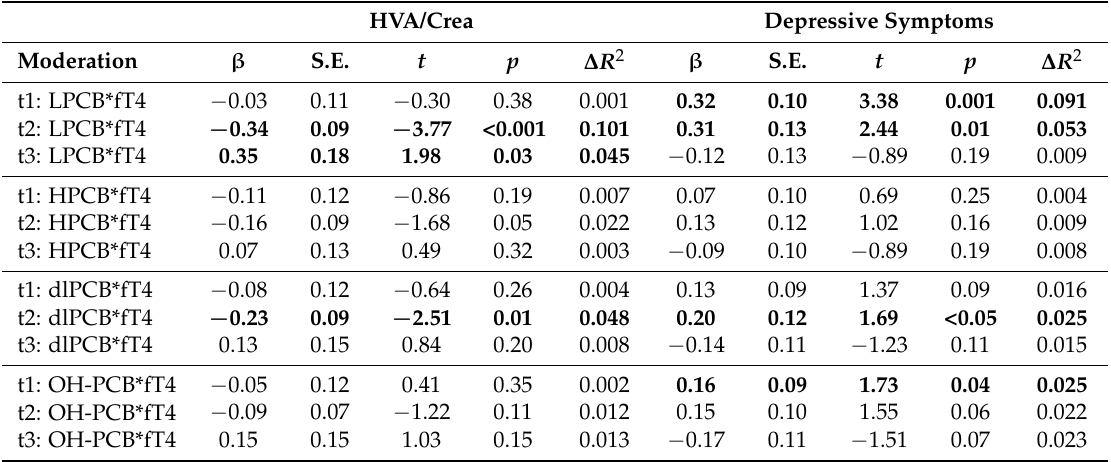
Table 3. Beta-coefficients for the moderation of lipid adjusted PCBs in terms of the association of fT4 with dopamine metabolite HVA/crea, as well as depressive symptoms at each measurement occasion. HVA/Crea Depressive